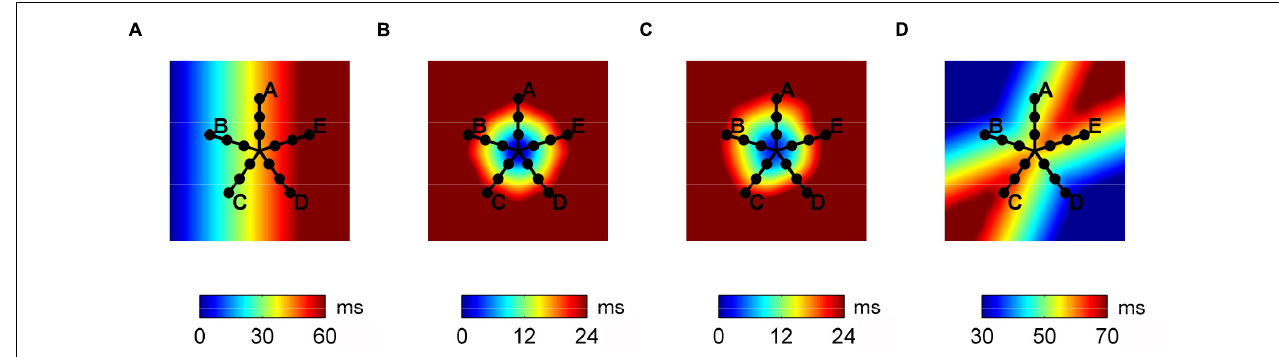
FIGURE 1 | Activation maps of the propagation patterns simulated on the tissue patch cellular automaton model and position of the simulated multipolar catheter. From left to right, plane wave propagation (A) , focal propagation in tissues with homogeneous (B) and heterogeneous (C) conduction properties, and wave collision (D)